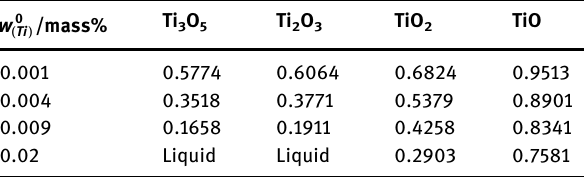
O , the concentration is bigger than As to Ti 3 5 that of the solid phase line but smaller than the O will liquid phase line, which means that Ti 3 5 always precipitate in the solid – liquid ( two - phase ) zones regardless of whether segregation occurs. O , TiO , and TiO, their concen - However, as to Ti 2 3 2 trations are smaller than both the respective liquid and solid phase lines, which indicate that the three kinds of Ti – O compounds will precipitate in the solid phase or not precipitate without consi - dering the element segregation. However, when segregation is considered, the most possibly pre - cipitate time of them is in the solid – liquid ( two - phase ) zones, as shown in the calculated results . for point P 1